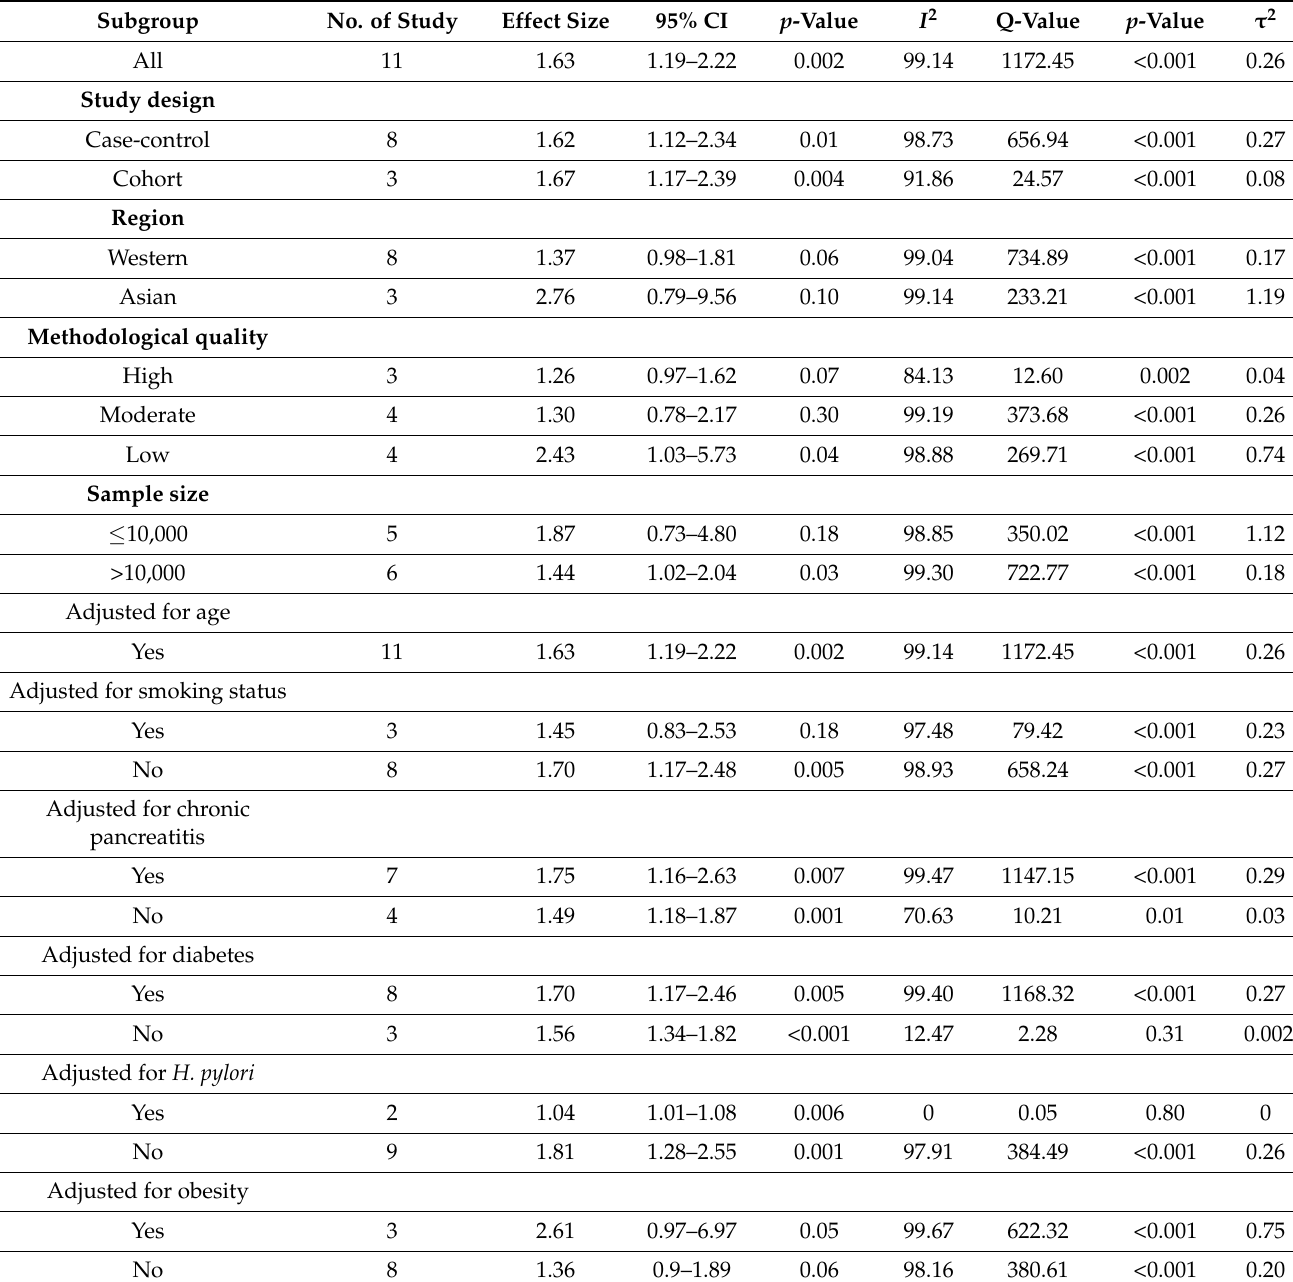
Table 1. Subgroup analysis of all